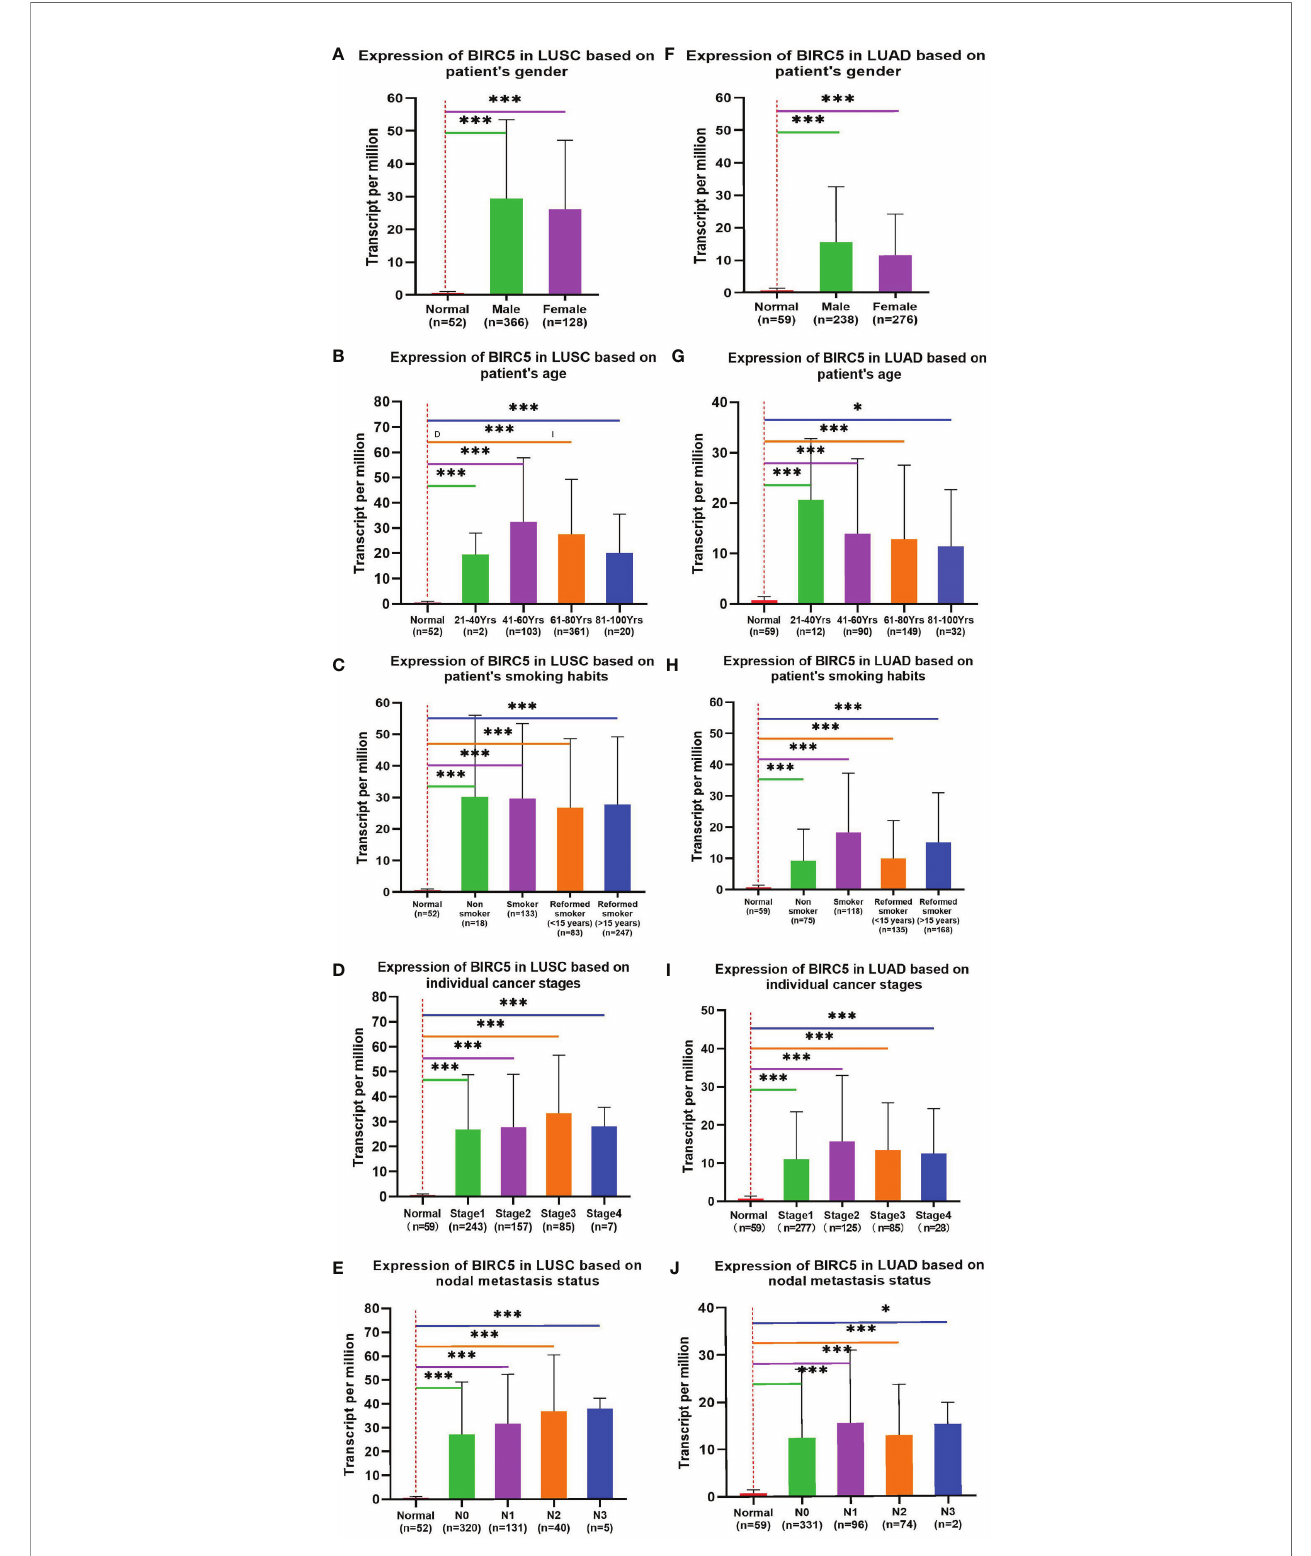
FIGURE 6 | Correlation between BIRC5 expression and tumor stage in LUSC (A – E) and LUAD (F – J) patients in UALCAN; *p < 0.05, **p < 0.01, ***p <